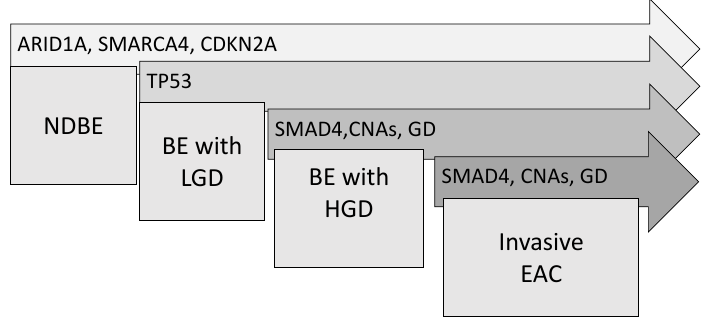
Figure 2. Model describing the progressive occurrence and accumulation of genetic alterations during the progression from non ‐ dysplastic Barrett’s esophagus to invasive EAC, through the intermediate stages first of Barrett’s esophagus (BE) with low ‐ grade dysplasia (LGD) and then BE with high ‐ grade dysplasia (HGD). This model is based on results of studies reported by Weaver et al. [21] and Ross ‐ Ines et al. [22].